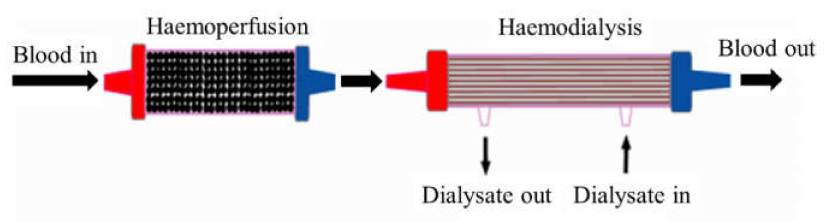
Figure 1. Integration of HD and